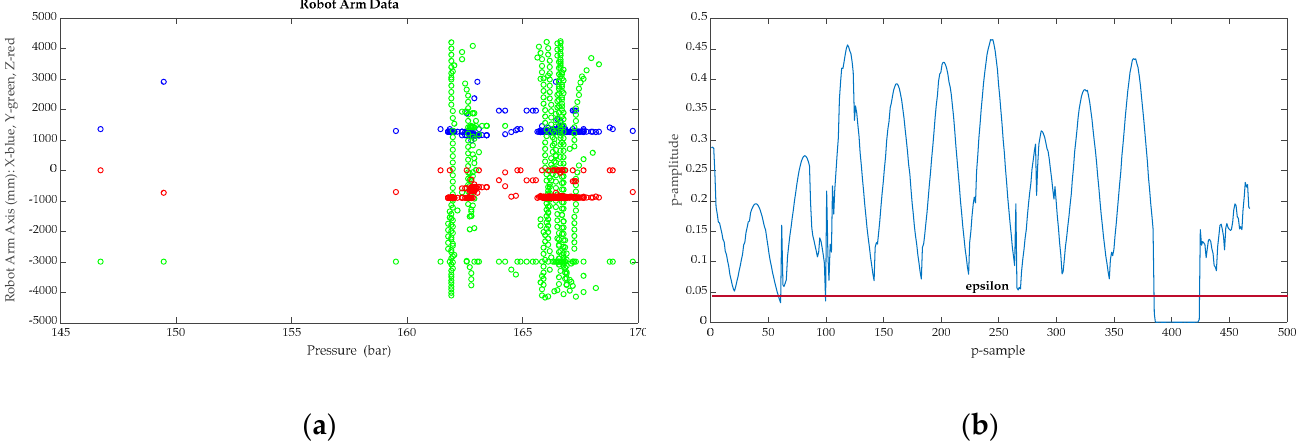
Figure 10. ( a ) The position arm axis related to hydraulic circuit pressure with about m = 468 samples for each feature. ( b ) Multivariate Gaussian distribution p ( x; µ , Σ ) .